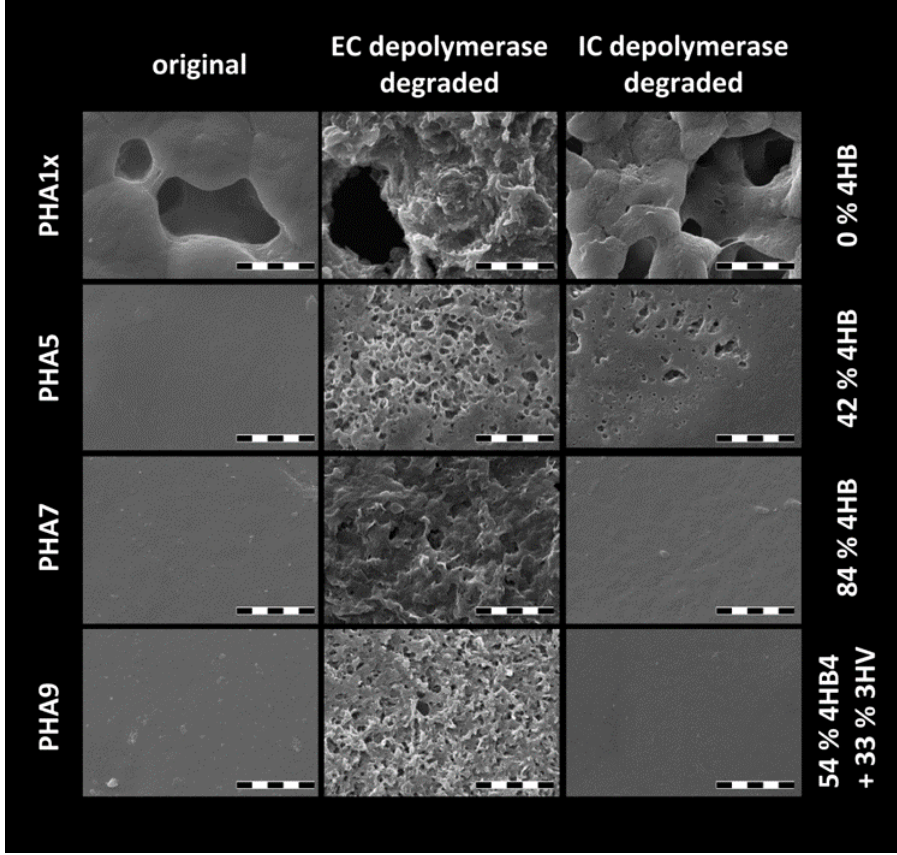
Figure 7. SEM micrographs of PHA copolymer films before and after the enzymatic degradation assay using extracellular (EC) PHA depolymerase and intracellular (IC) PHA depolymerase, respectively (magnification 10,000×, scalebar: 10 µm).